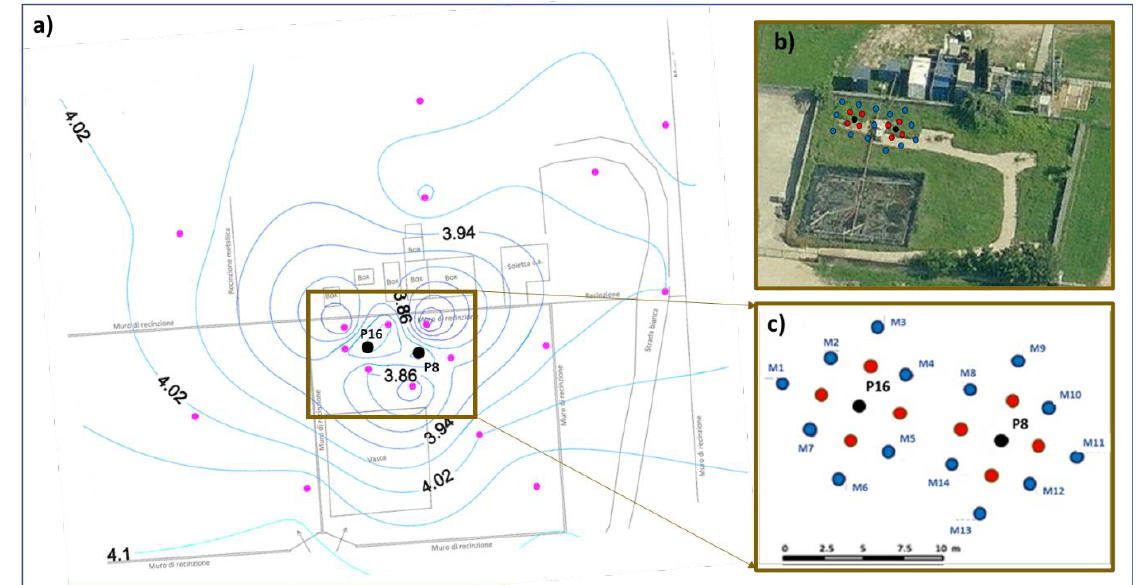
Figure 1. ( a , b ) Plan view of the site, with detail ( c ) of the pilot area including the monitoring well distribution: the monitoring wells P8 and P16 are in black while the monitoring wells for the detailed pilot area characterization of are in blue (red points indicate other wells not used for the purpose of this study); blue lines ( a ) are piezometric lines of the upper confined aquifer.